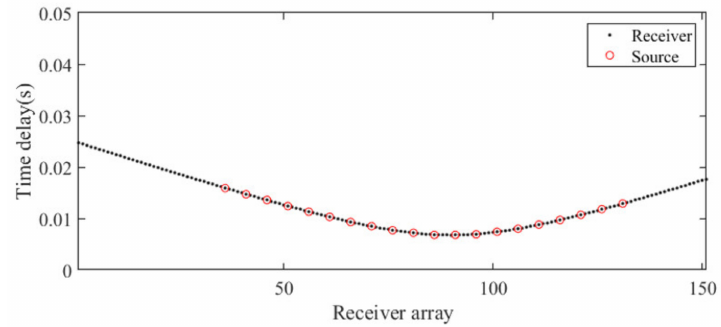
Figure 3. Time delay of each receiver and